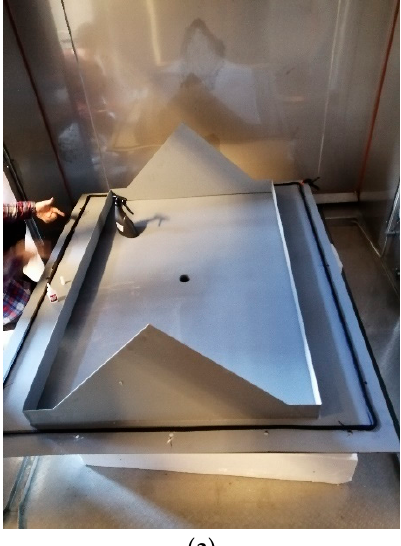
Figure 1. Climatic chambers Weiss Umwelttechnik HmbH, internal dimension 2 × 2 m: ( a ) outdoor chamber with the specimen; ( b ) indoor chamber and a masking panel.